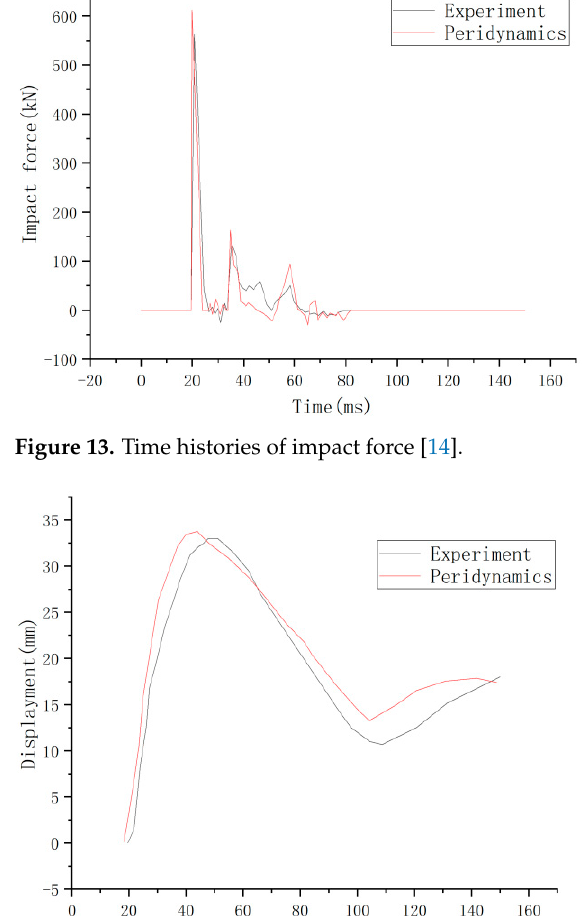
Figure 14. Midpoint displacement of the wall [14].